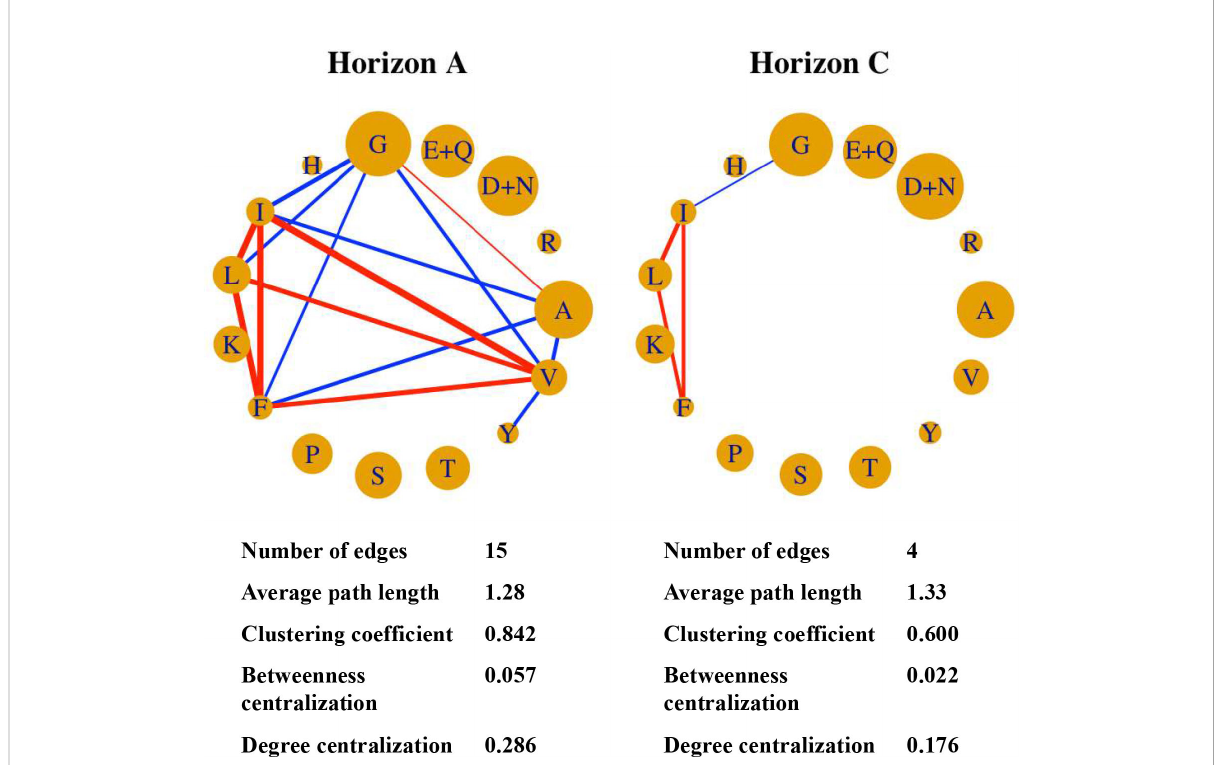
FIGURE 3 HAAs in soils from A-horizon have a stronger coupling distribution compared to those from C-horizon, supported by the network analysis. The single letters in blue represent the corresponding amino acids. Connected lines represent rubust correlations (r > 0.6, p < 0.05). Red and blue lines represent positive and negative correlations. The thickness of the line represents the absolute value of the correlation coef fi cient. A, Ala; R, Arg; G, Gly; H, His; I, Ile; L, Leu; K, Lys; M, Met; F, Phe; P, Pro; S, Ser; T, Thr; Y, Tyr; V, Val; D, Asp; N, Asn; E, Glu; Q,